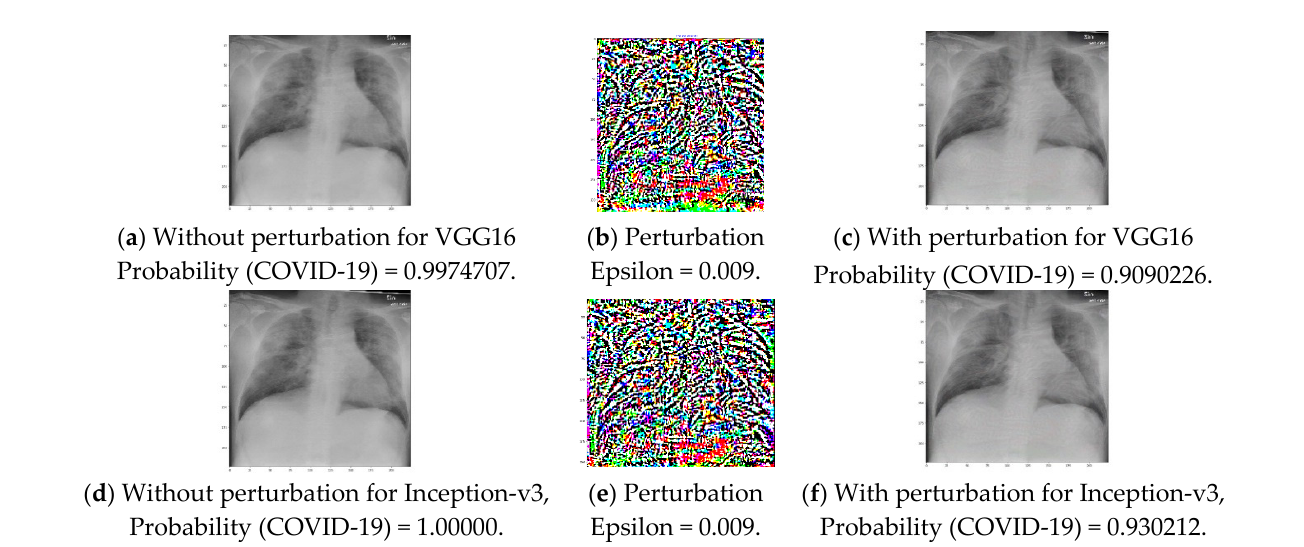
Figure 8. Sample drop of class probability score for successfully classified adversarial chest X-ray images. Table 5. Average drop of predicted correct class probability for adversarial chest X-ray images.